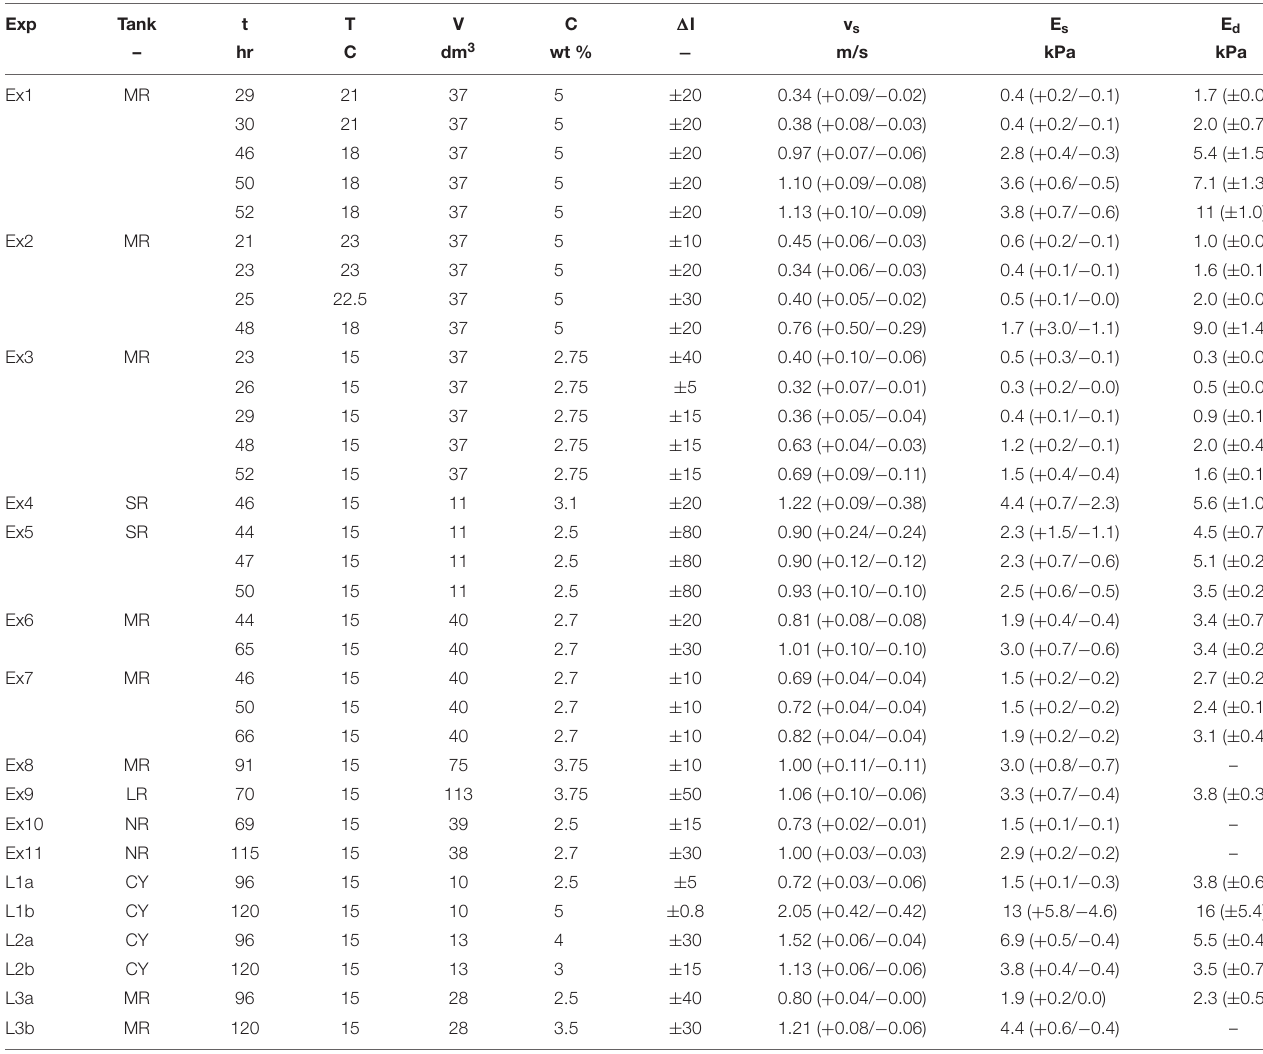
TABLE 1 | Experimental conditions and